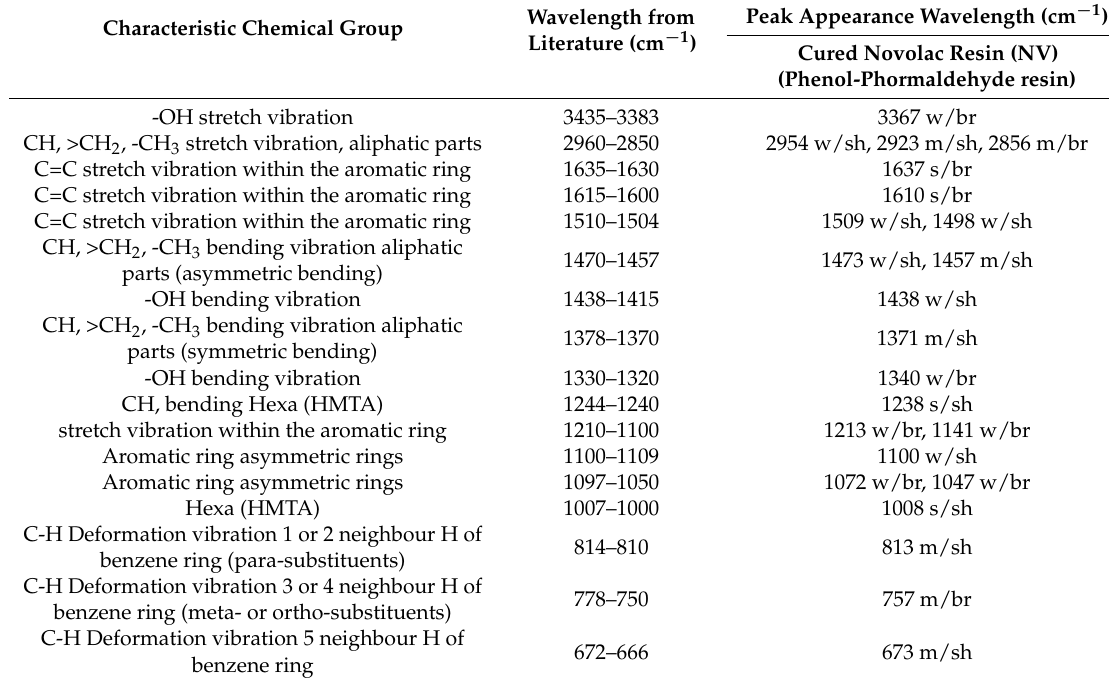
Figure 4. Infrared Spectroscopy via Fourier Transformation (FT-IR) spectra from specimens with 0–20% content in BaTiO 3 nano-particles in the M 3 A 4 PA 3 , at a wavelength range between: 4000–200 cm − 1 ( left ) and 1800–350 cm − 1 ( right ). Table 6. FT-IR spectra characteristic peaks from the novolac resin (NV).